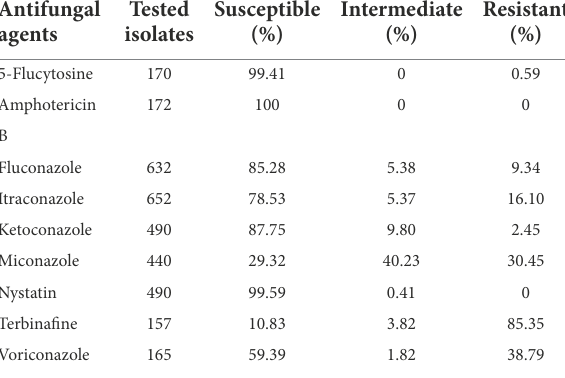
TABLE 3 Antifungal susceptibility profile of C. albicans for all tested drugs in the past 10 years. Antifungal